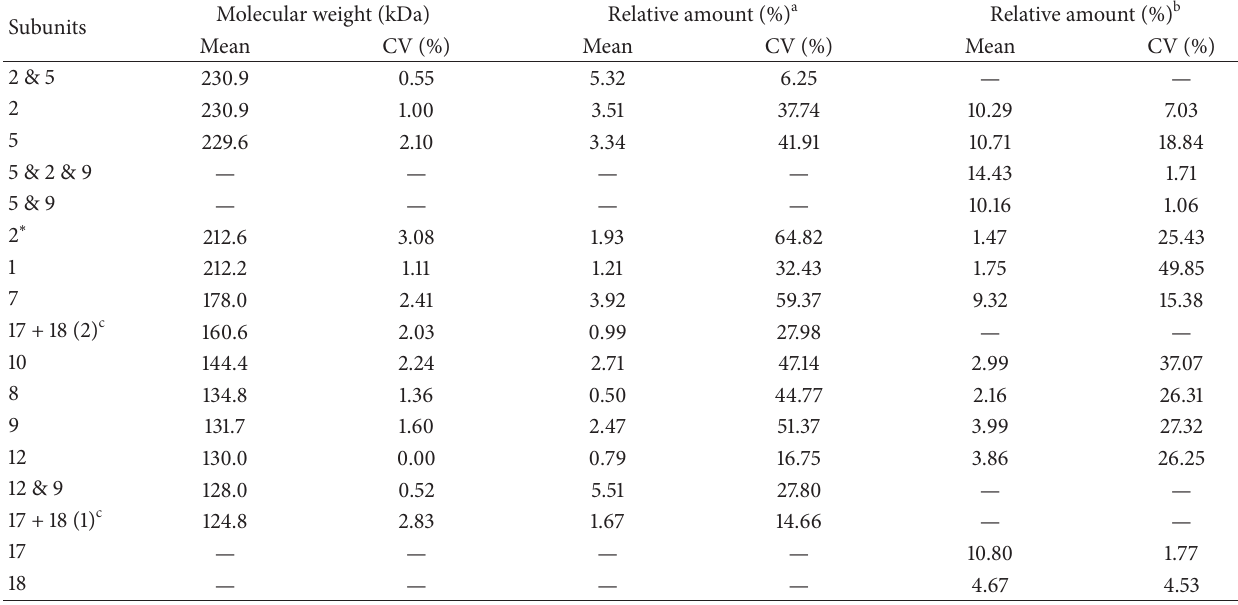
Table 1: Apparent sizes and quantification of individual HMW-GS subunits for all examined bread wheat cultivars by LoaC method and quantification of individual HMW-GS subunits by